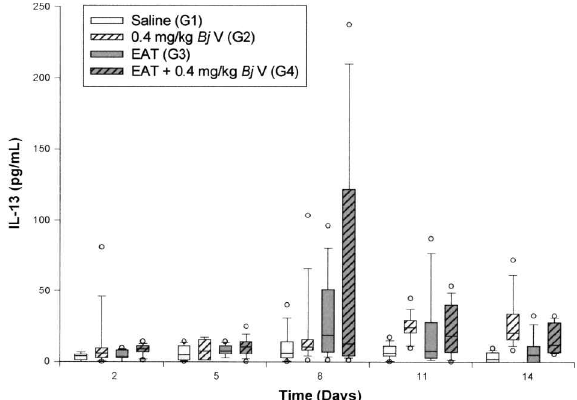
FIG. 5. Box plot of the TNF- a level kinetics in EAT cells treated with Bj V. Each box represents 25–75% values with the median as an internal line, the error bar represents 10% and 90%, and the circle represents the outliers. Statistics: 14th day, G3 > (G1 = G2); p <